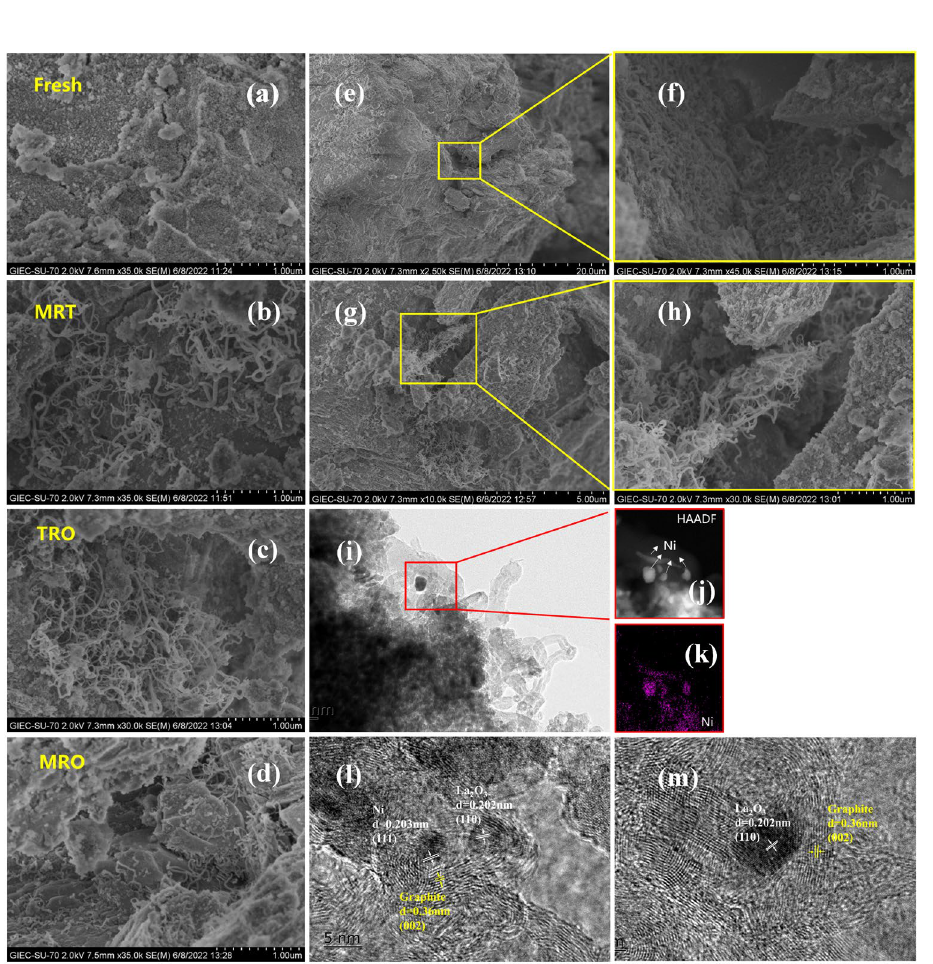
Figure 4. SEM images of ( a ) fresh catalyst and the solid carbon deposition on the spent catalysts obtained from the ( b ) MRT, ( c ) TRO and ( d ) MRO processes and ( e – h ) carbon fibres blocking the channels on the catalyst surface; ( i ) TEM image, ( j ) HAADF image and ( k ) EDX elemental map for Ni in the spent catalyst under TRO process and ( l , m ) HRTEM images of the spent catalyst from MRO. (Benzene content: 29.6 g/Nm 3 , discharge power: 35 W, reaction time: 2 h, temperature: 450 °C.)